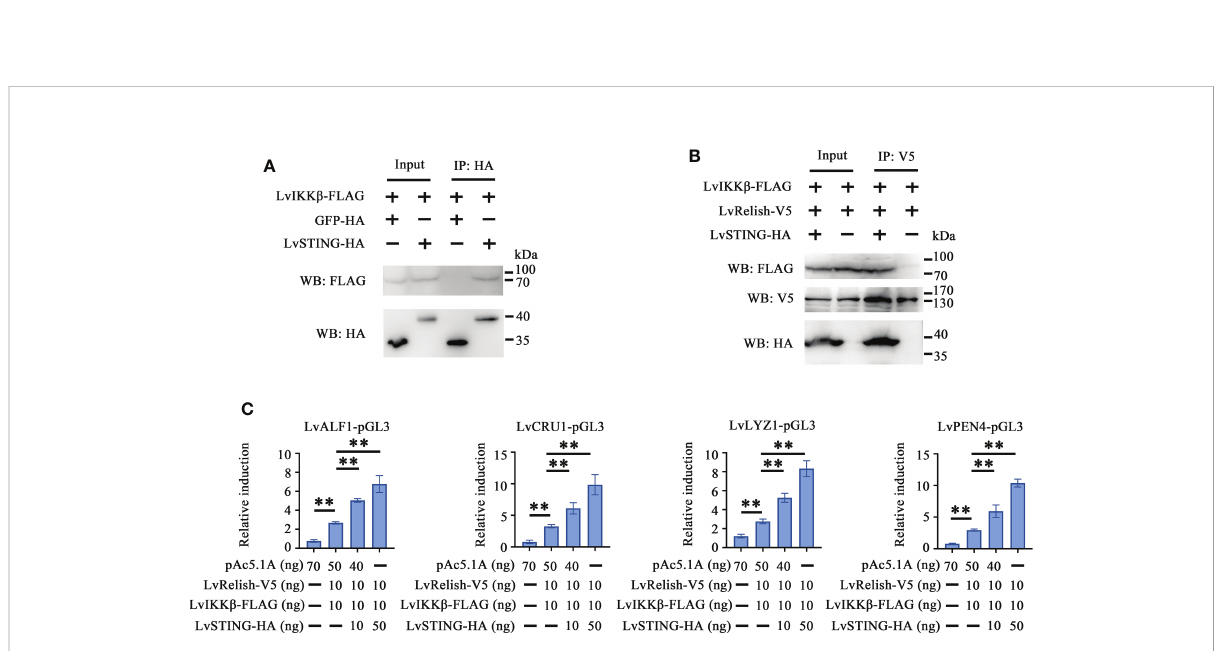
FIGURE 5 LvSTING recruited LvIKK b and LvRelish to induce the promoter activities of AMPs in vitro . (A) The Co-IP assays con fi rmed the interaction between LvSTING and LvIKK b . (B) The Co-IP assays proved that LvSTING recruited LvRelish and LvIKK b . (C) The promoter activities of shrimp AMPs induced by LvIKK b and LvRelish could be upregulated by ectopic expression of LvSTING in a dose-dependent manner. The data was analyzed statistically by student ’ s T test (** p <